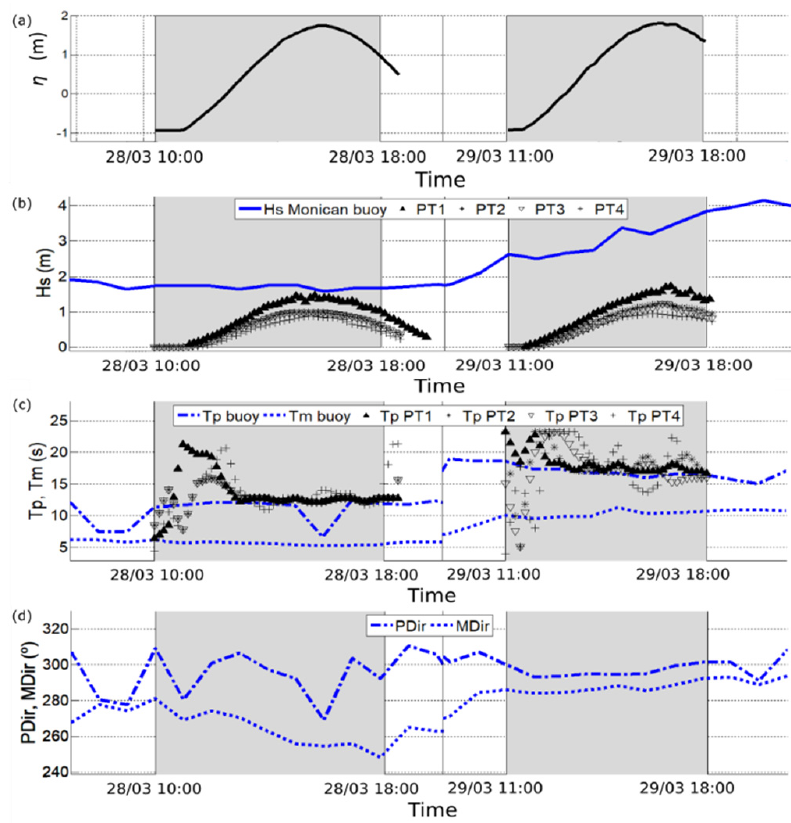
Figure 2. Hydrodynamic conditions during the experience: ( a ) water level η measured by the most seaward PT; ( b ) significant wave height H s measured by Monican buoy (blue line) and PTs (symbols) in the intertidal area; ( c ) wave period from buoy (lines) and from PTs (symbols); and ( d ) wave direction from buoy. Gray rectangles indicate the intervals in which video data are available.